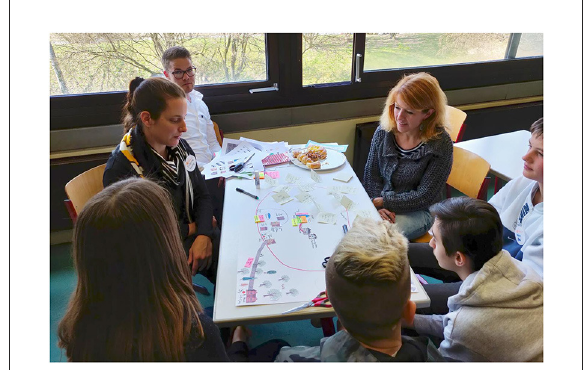
FIGURE10 Researchers and students jointly designing and playtesting the game concept based on a paper prototype.